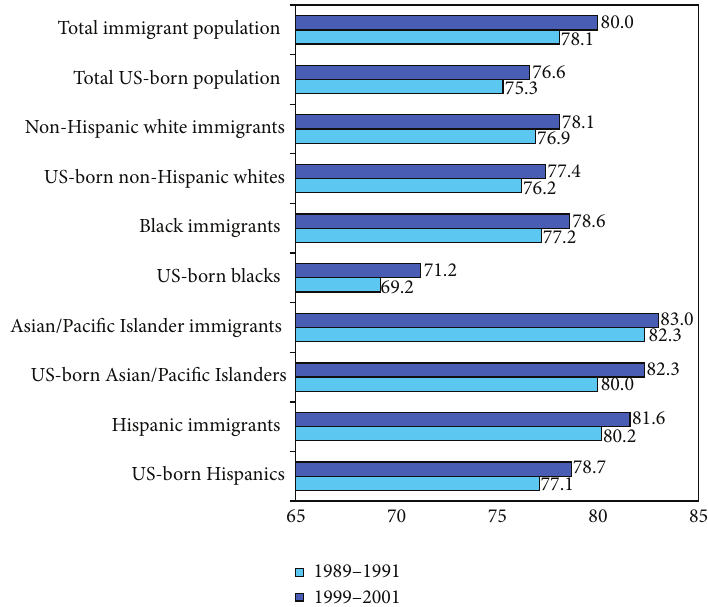
Figure 1: Life expectancy at birth (average lifetime in years) by race/ethnicity and immigrant status, United States, 1989–2001. Source: based on data from the US National Vital Statistics System, 1989–2001. Also, see [7].